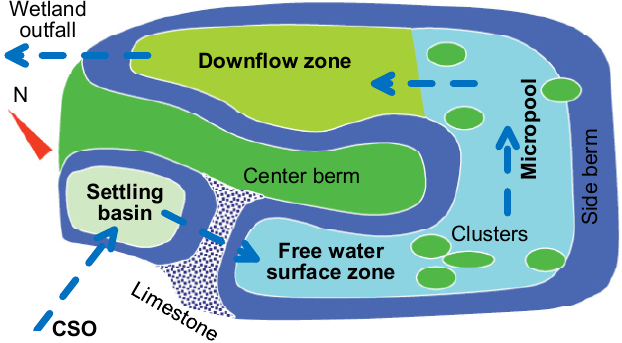
Figure 3. Layout of Arch/Bar CSO constructed wetland at Elkhart, Indiana.